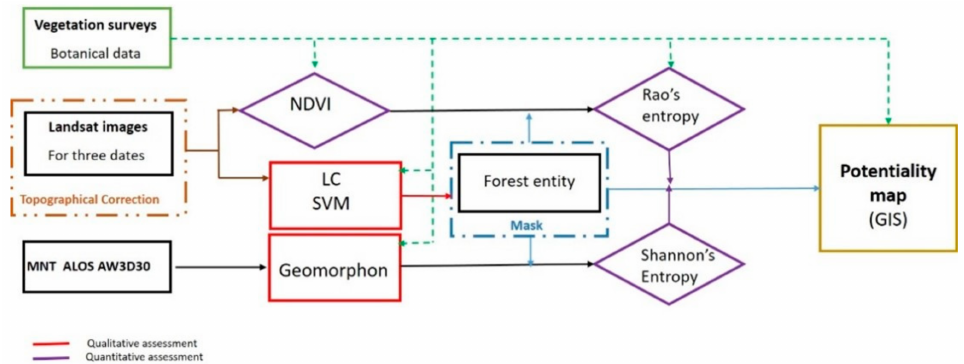
Figure 1. General scheme summarizing the method.